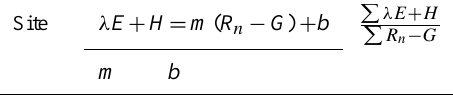
Table 1. Watershed and precipitation characteristics at the SRER and JER sites. Precipitation values are long-term averages (1923– 2014 at SRER and 1915–2006 at JER) for annual and seasonal quantities, defined as fall (October–December), winter (January– March), spring (April–June), and summer (July–September). Note that individual vegetation species have been generalized into three functional types.